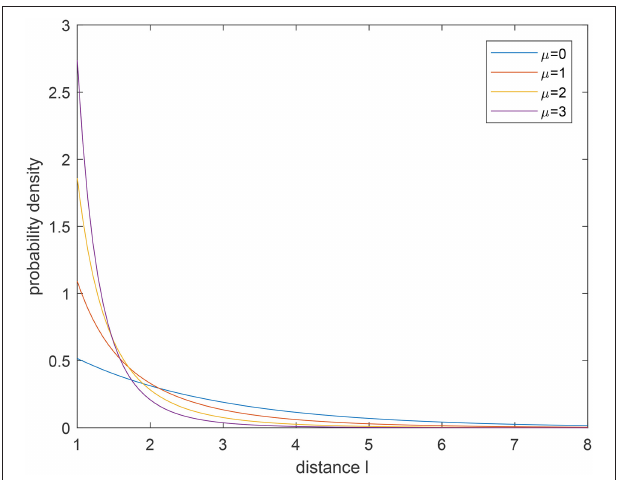
FIGURE 2 | Probability density for tempered Lévy distribution with ρ = 0.5 for different µ .